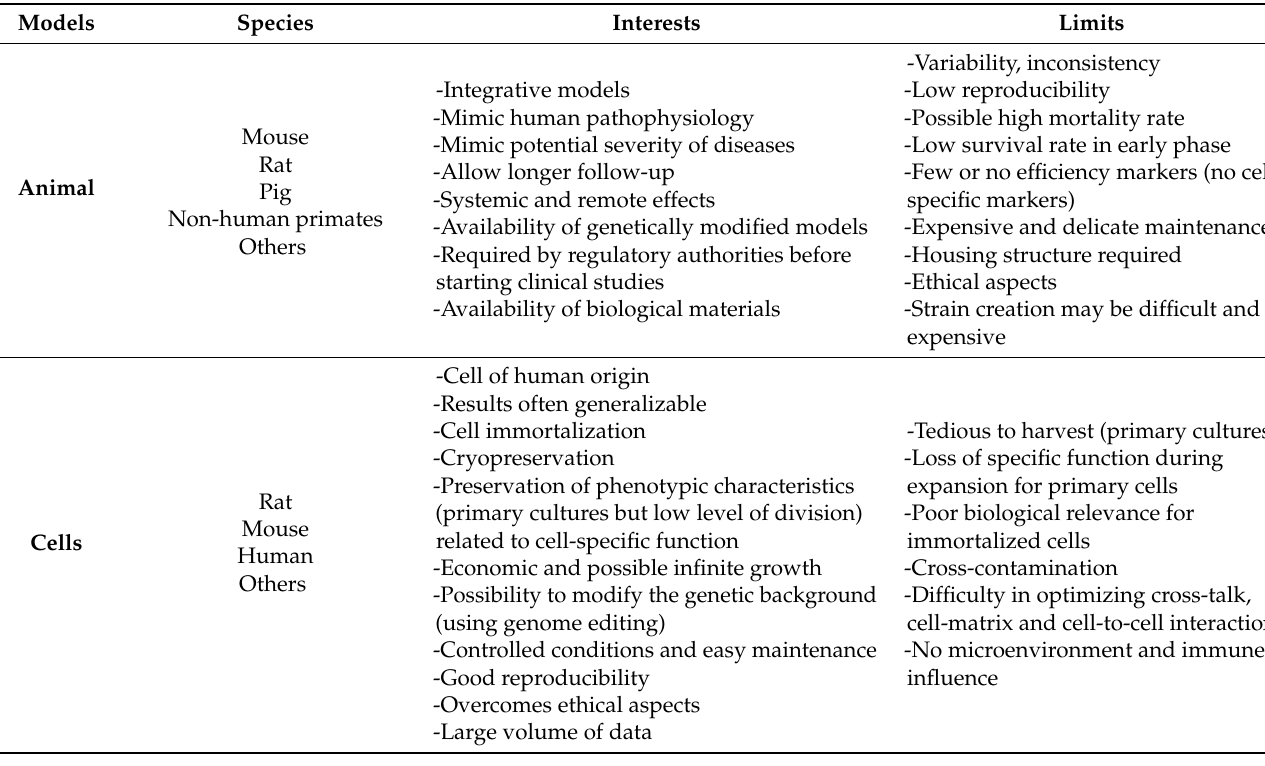
Table 3. Main interests and limits of different models (non-exhaustive